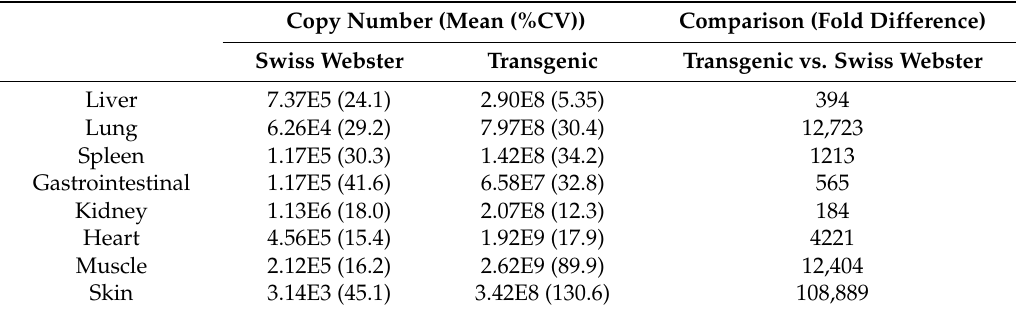
Table 1. Expression of mouse neonatal Fc receptor (mFcRn) and human neonatal Fc receptor (hFcRn) mRNA in various tissues of Swiss Webster and transgenic mice.